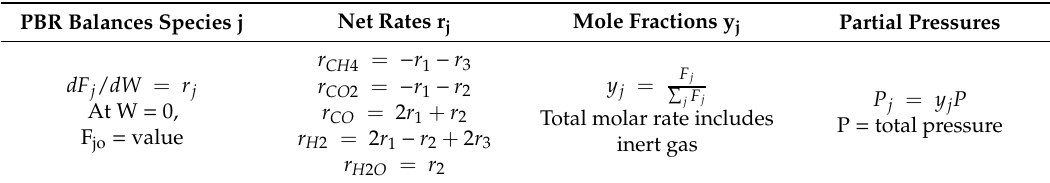
Table 4. Key packed-bed reactor (PBR) simulation equations using 3-reaction global model (Table